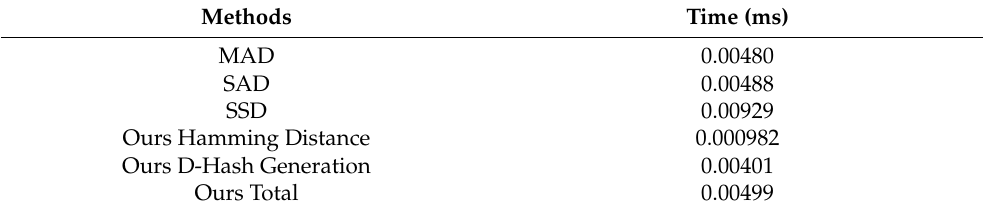
Table 4. Time comparison of different distance functions.